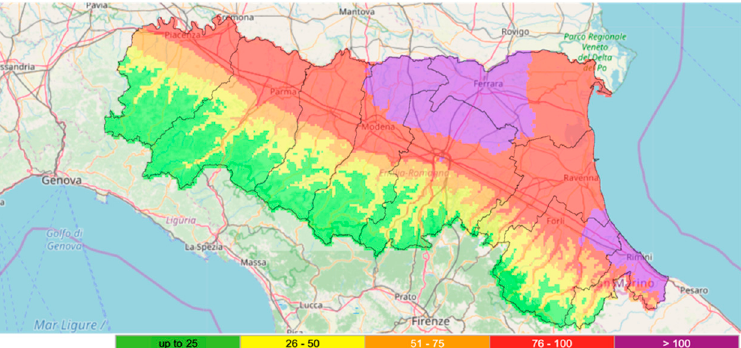
Figure 2. Exemplifying map of the particulate matter (PM 10 ) levels (expressed as µg m − 3 ) reached in the Emilia-Romagna region, whose Northern/Western part is comprised in Italy’s Po Valley. Date: 16 January 2020, illustrating the recurrent situation on a number of many autumn/winter days. Printed by permission of the Environmental and Energy Protection Agency of Emilia-Romagna (ARPAE; http://www.arpae.it/, suite modelling “NINFA”), kindly acknowledged.